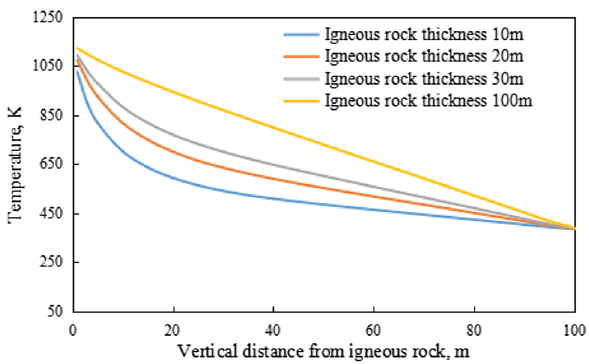
Fig. 7 Relationship curve between maximum reservoir temperature and distance between reservoir and igneous